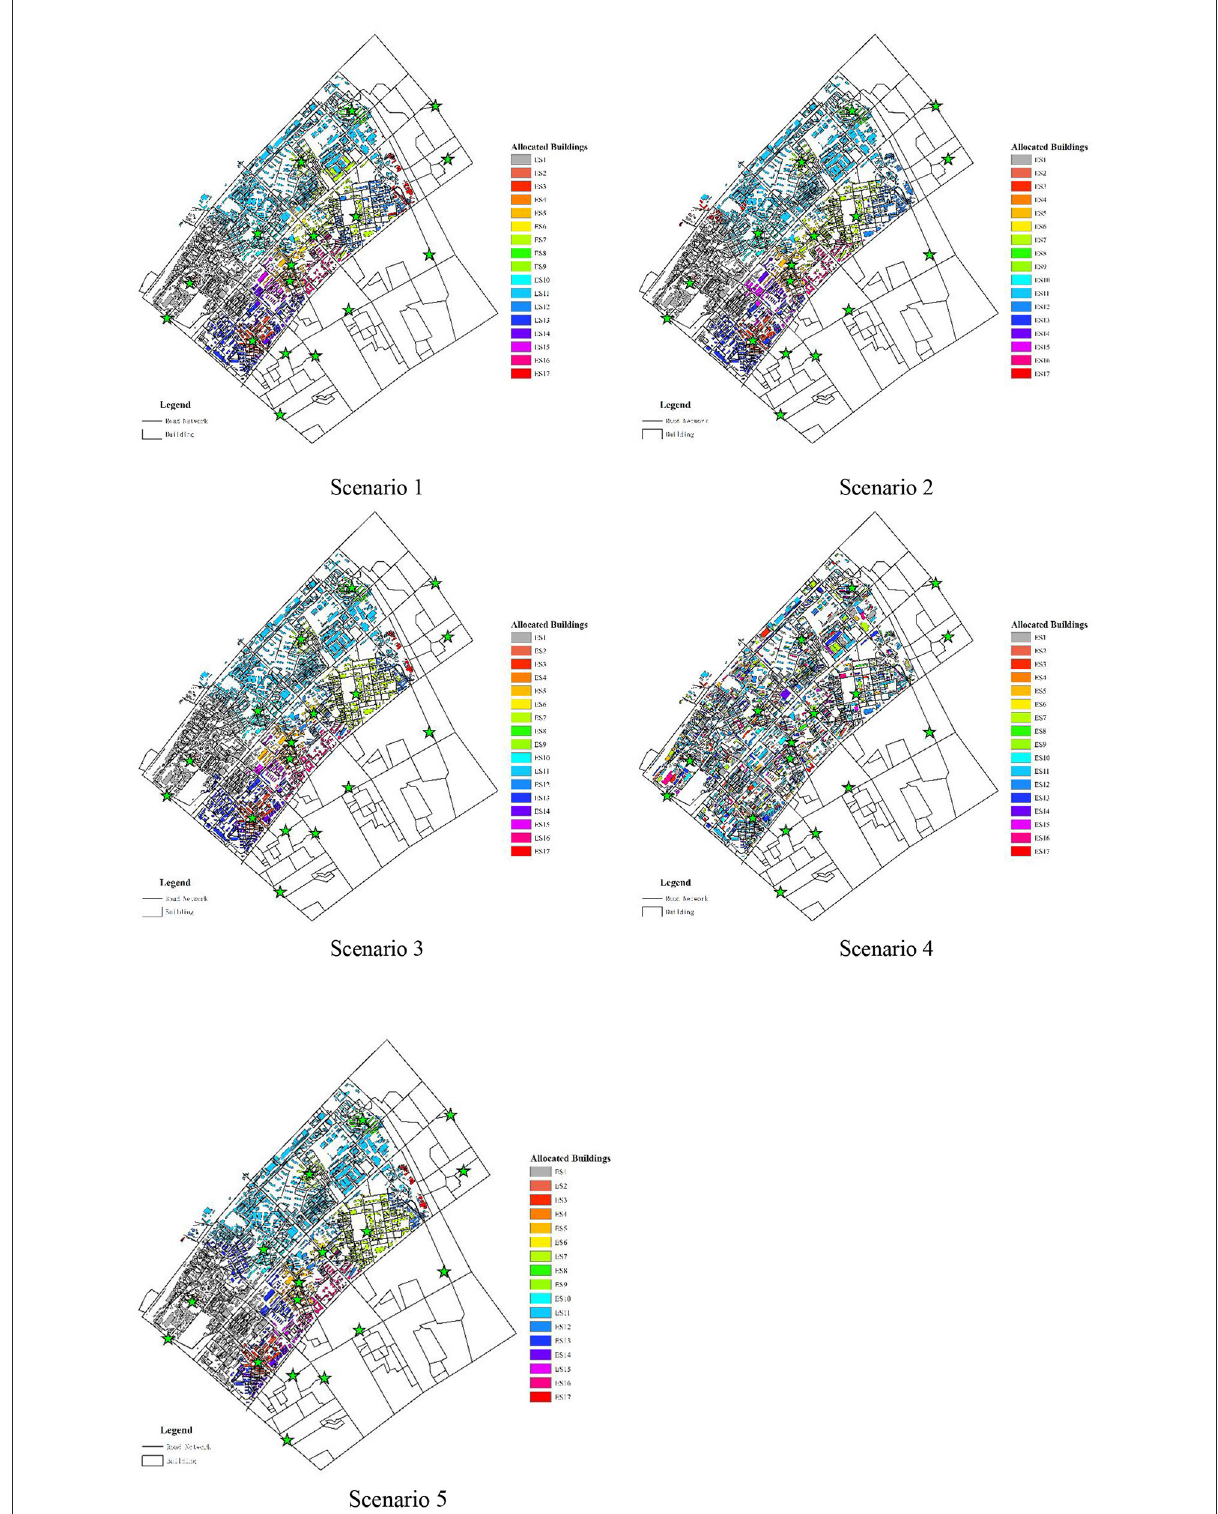
FIGURE10 The allocation results of shelters for five